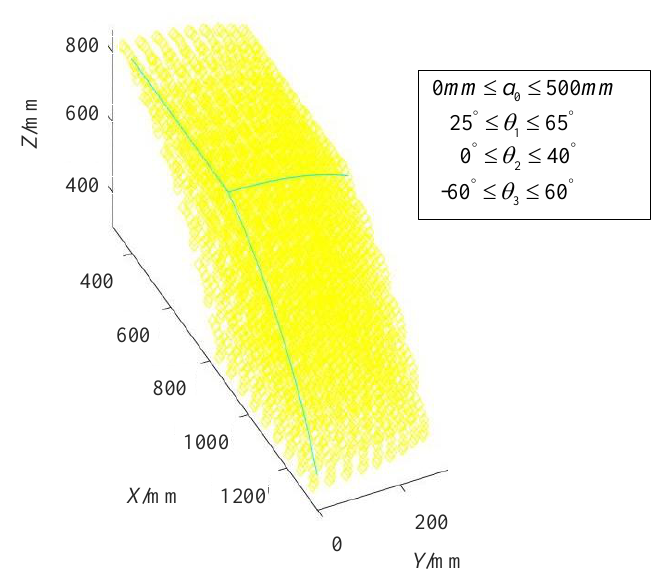
Figure 9. The spatial workspace of the robot.